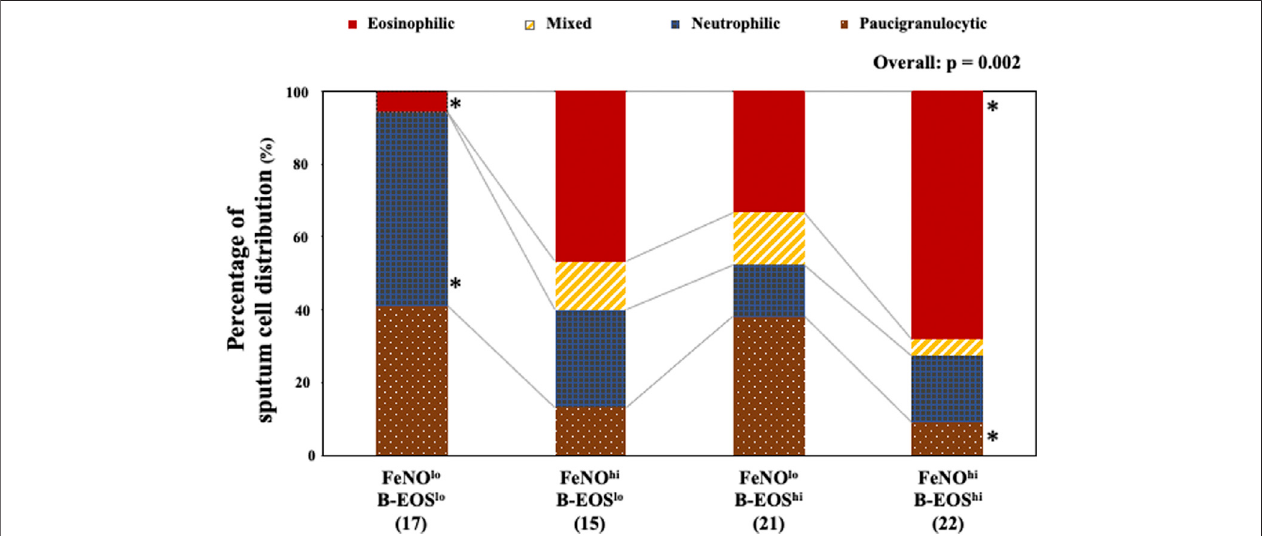
FIGURE3| Distributionofsputumgranulocyte-predominantsubtypesinthetype2biomarker-classi fi edsubgroups.Ofsuccessfulsputuminduction,75adequate sputum samples were examined. Patients were divided into four subtypes according to the cutoff values of sputum eosinophilia ( ≥ 2.7%) and predominant neutrophil ( ≥ 50.0%). Values were analyzed using Fisher ’ s exact test. In the FeNO lo /B-EOS lo subgroup, the eosinophil-predominant, mixed-granulocyte, neutrophil-predominant, and paucigranulocyte subtypes were as follows: 5.9, 0.0, 52.9, and 41.2%, respectively. In the FeNO hi /B-EOS lo subgroup: 46.7, 13.3, 26.7, and 13.3%, respectively. In the FeNO lo /B-EOS hi subgroup: 33.3, 14.3, 14.3, and 38.1%, respectively. In the FeNO hi /B-EOS hi subgroup: 68.2, 4.5, 18.2, and 9.1%, respectively. FeNO lo , low FeNO; FeNO hi , high FeNO; B-EOS lo , low B-EOS; B-EOS hi , high B-EOS. *, signi fi cantly high or low, compared with the other FeNO/B-EOS subgroups.